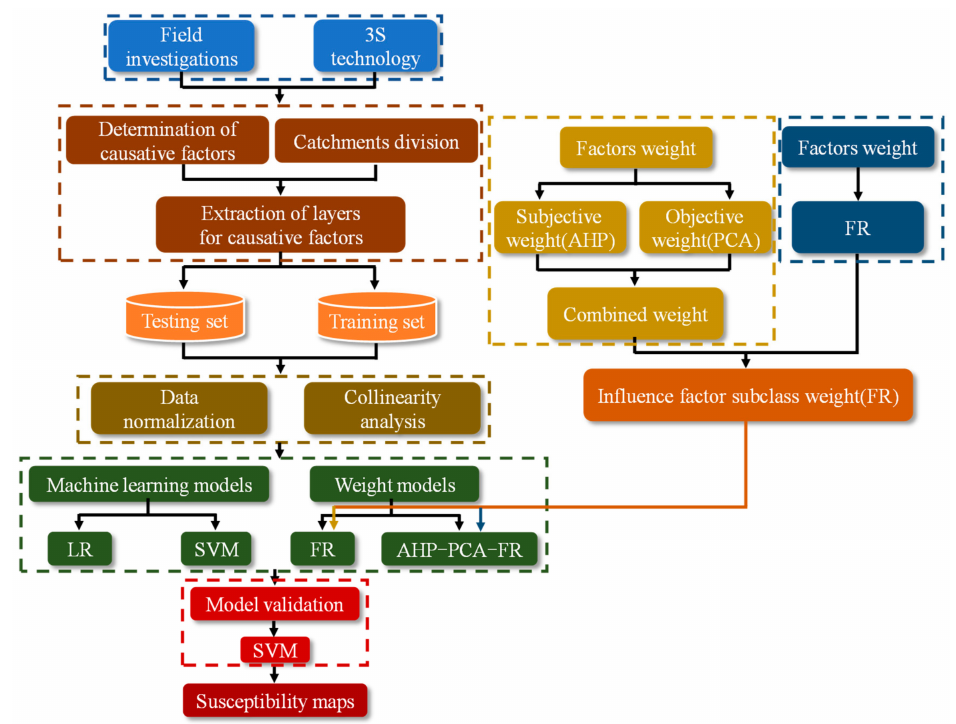
Figure 4. The modeling flow chart of this